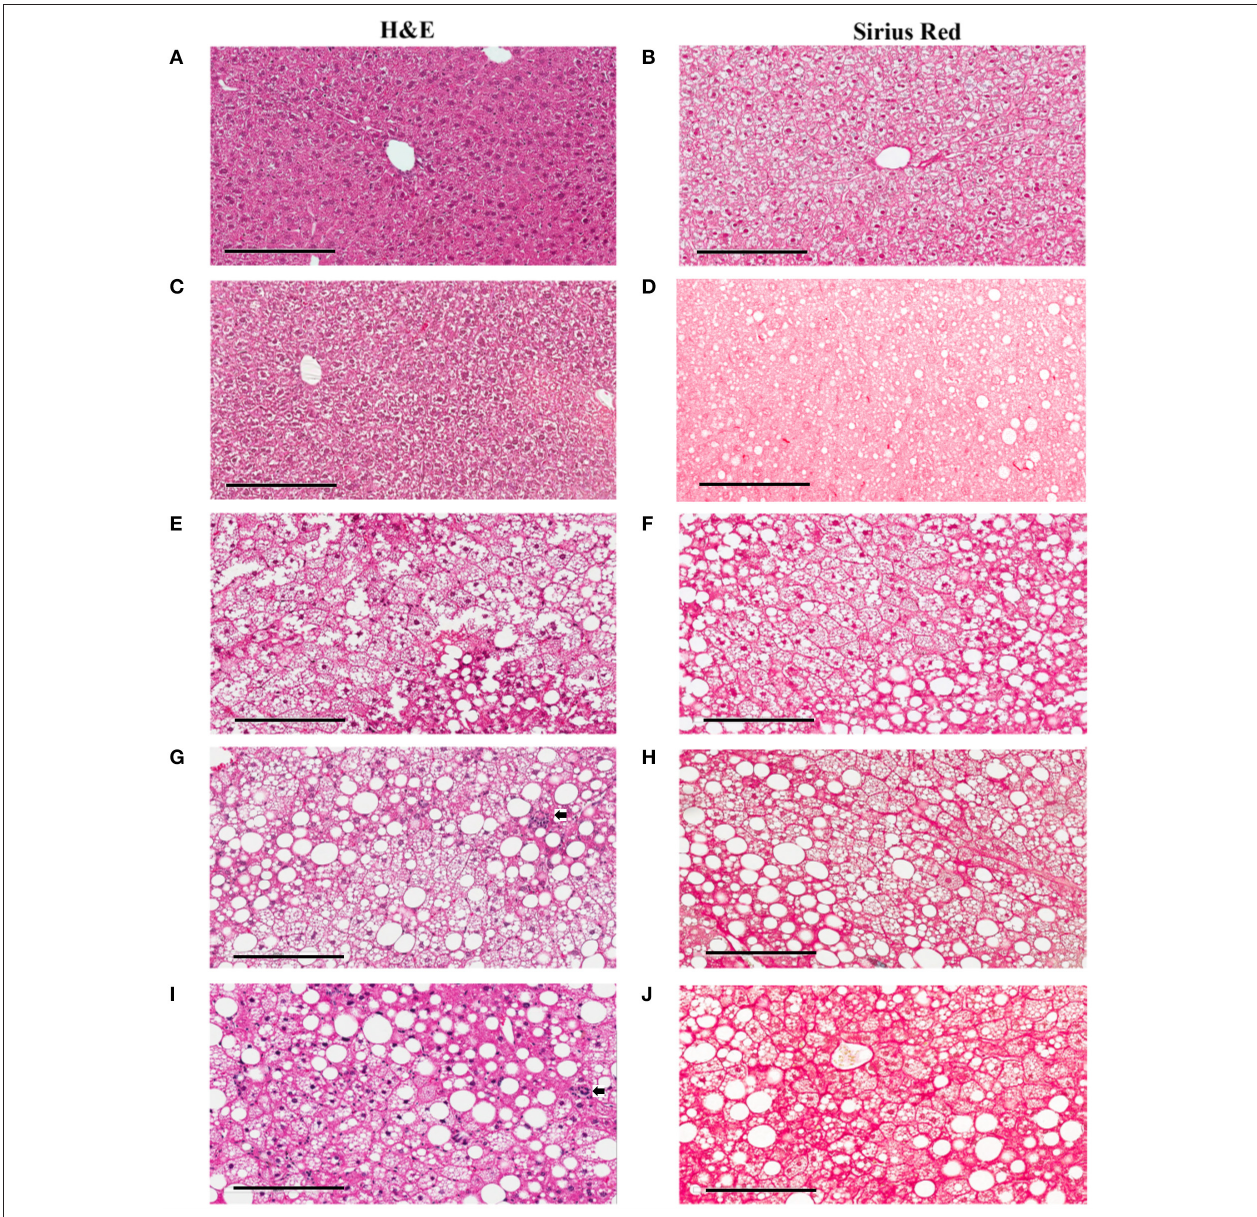
FIGURE 3 | Hepatic lesions of the NASH Mice at Different Age. The representative images were taken from the liver sections of the mice fed either rodent chow (A,B) or Western diet for 60 (C,D) , 150 (E,F) and 245 (G,H) , and 352 (I,J) days respectively. (A,C,E,G,I) are the images of the liver sections stained with H&E; Panels (B,D,F,H,J) are the images of the liver sections stained with Sirius Red.